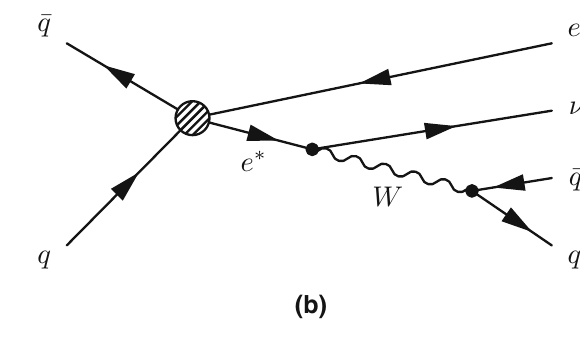
Fig. 2 Feynman diagrams for a ee ∗ → eeq ¯ q and b ee ∗ → e ν